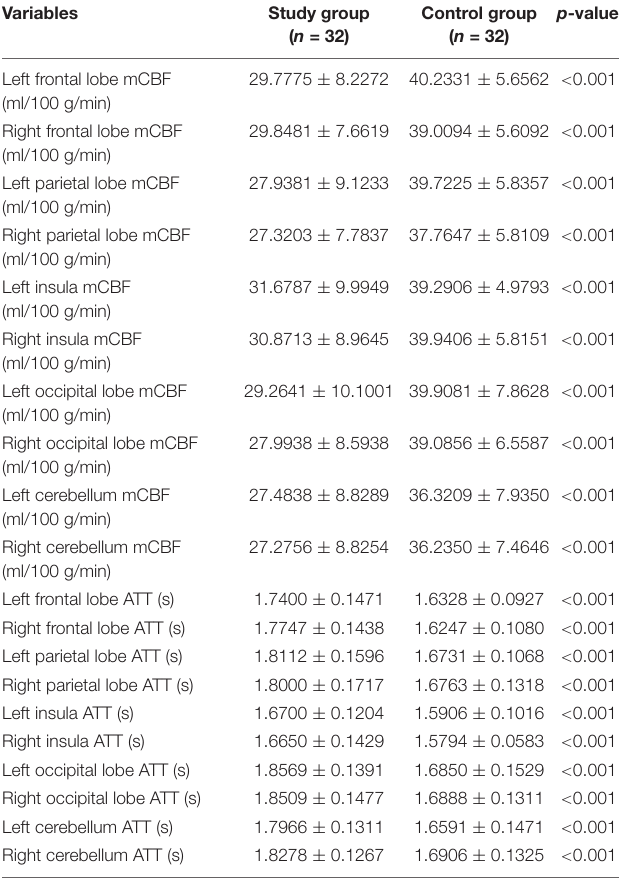
TABLE 1 | Comparison of the mCBF and ATT of all parts between the study and control